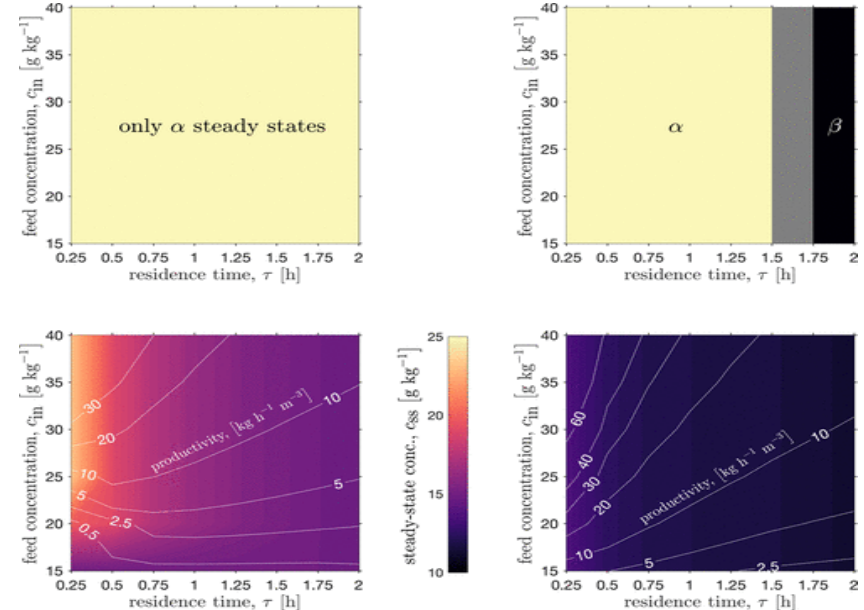
Figure 8. Process intensification of continuous crystallization + milling for polymorph selection. Reproduced with permission from Köllges and Vetter, Organic Process Research & Development; published by American Chemical Society, 2019 [58].